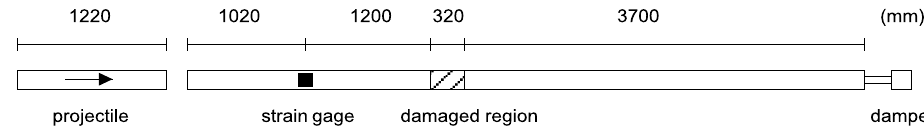
Fig. 26. Experimental pulse-echo setup. Dimensions are in millimeters.